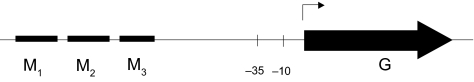
The simulated gene structure. M1, M2 and M3 are three simulated transcriptional factor binding sites and the basal promoter element represented by the -35 and -10 regions. The combination of the three motifs with the basal promoter element was random. The motif effects could be negative, positive or have no effect.